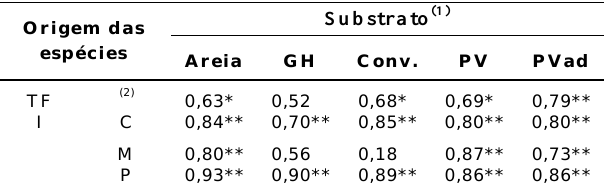
Quadro 5. Coeficientes de correlação entre crescimento em altura e tamanho da semente (comprimento) de 16 espécies de leguminosas arbóreas, oriundas de terra firme (TF), e de 33